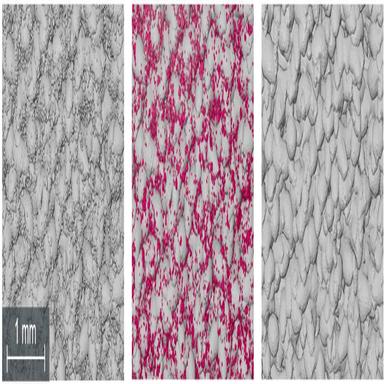
3D rendering of the original "raw" dataset (left) with highlighted powder particles (center) and the filtered structure's surface (right) of sample 4. The bottom row shows a magnification of a cubic cut of the volume renderings seen in the upper row.